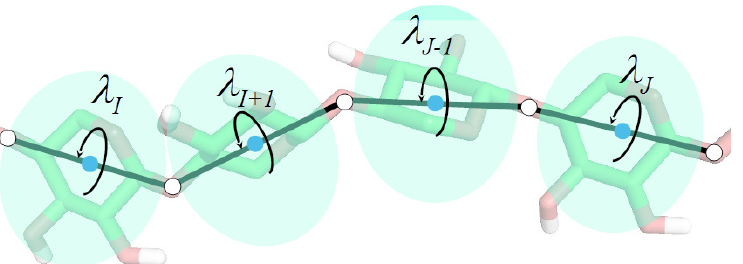
Figure 1. An illustration of coarse graining with the example of a chunk of poly- α -D-glucose chain. The spheroids (anchored in the glycosidic-oxygen atoms) represent united sugar rings and the angles λ for the rotation about the O · · · O virtual bond axes are the secondary degrees of freedom, which are not present in the CG